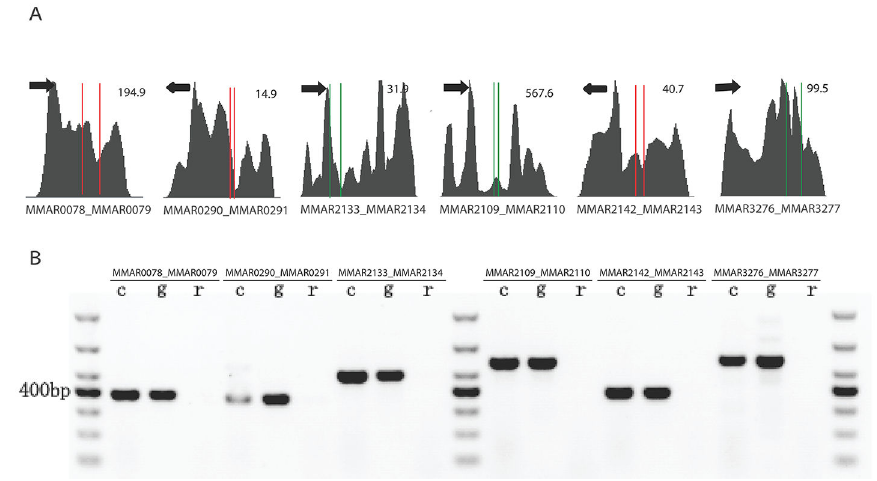
Figure 3. Sequencing traces of select putative operons and RT-PCR results. (A) Sequencing data of amplified regions. Numbers on upper right corner indicate the highest coverage of selected regions. Red lines indicate gene boundaries, green lines shows overlapped regions of two genes. Black arrows indicate direction of transcription. (B) Products of RT-PCR for 6 co-operonic gene pairs (1% agarose gel). c=cDNA template. g=genomic DNA template. r=RNA template. doi: